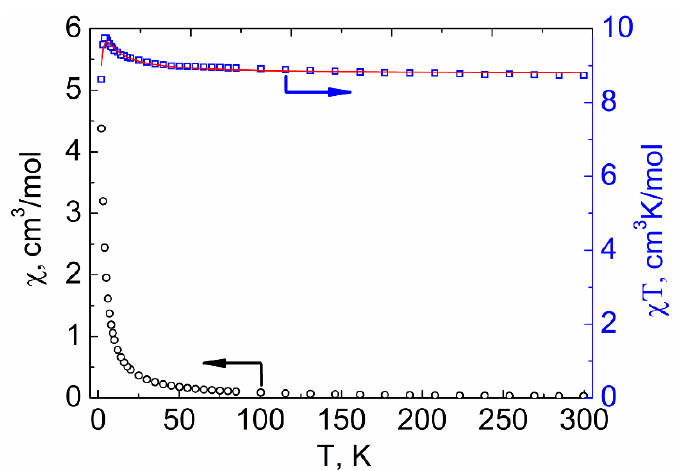
Figure 9. Temperature dependencies of the χ M T product ( □ ) and χ M ( ○ ) for compound 2 . The red line shows the values calculated using PHI [48] program.